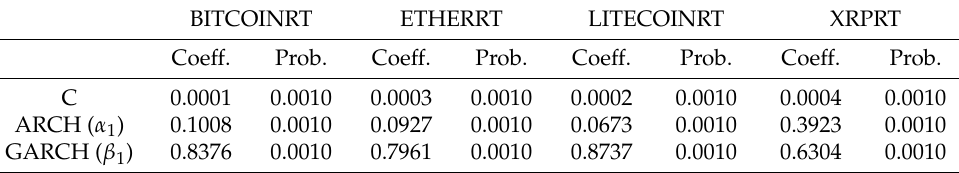
Table 9. GARCH Model.